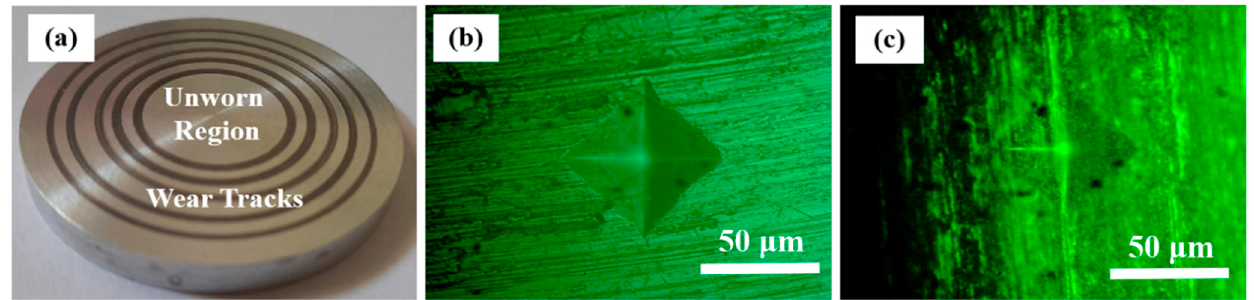
Figure 10. ( a ) Al alloy disc tested with PAO + h-BN + ND nanolubricant at 50 N. Microhardness indentation ( b ) on unworn region of Al alloy disc surface (hardness: 148 Hv), magnification 40× and ( c ) on the wear track of Al alloy disc tested with PAO + h-BN + ND nanolubricant at 50 N (hardness: 190 Hv), magnification 40×.